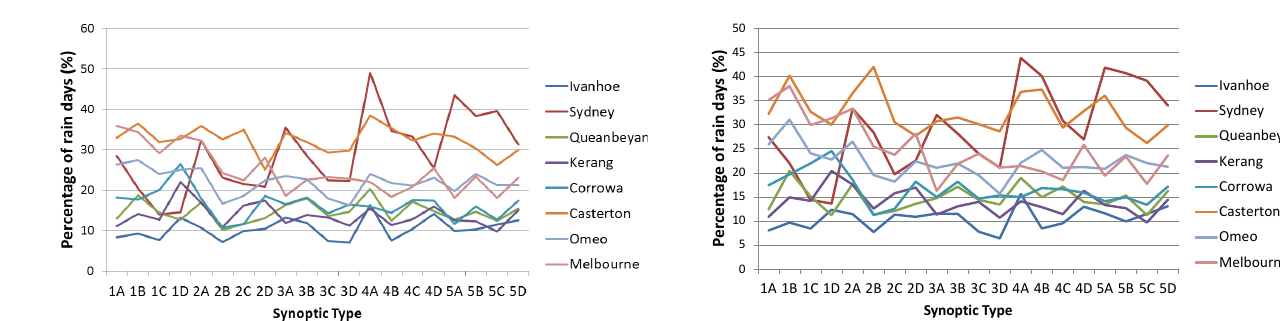
Figure 13. Percentage of rain days associated with each autumn synoptic type.